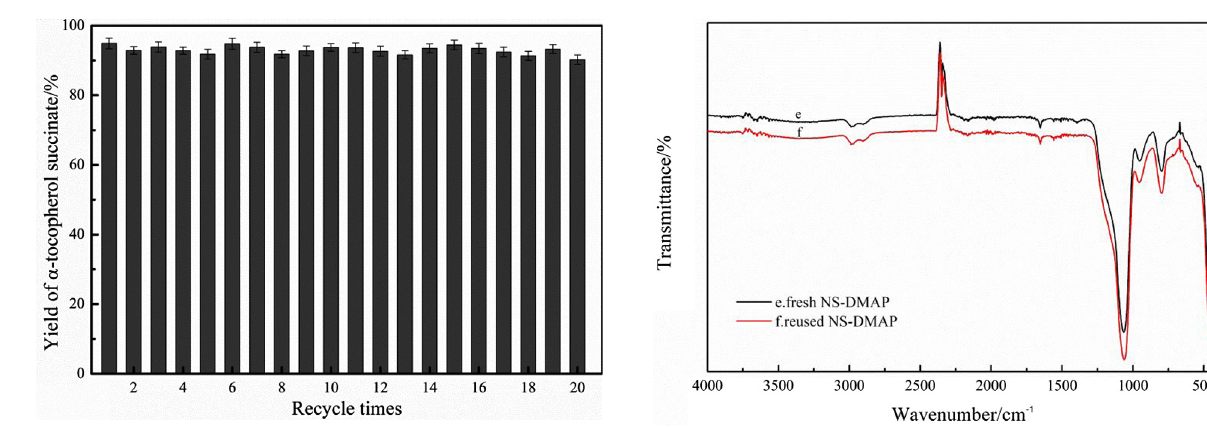
Figure 11: Comparison of FT-IR for fresh catalyst with reused catalyst.